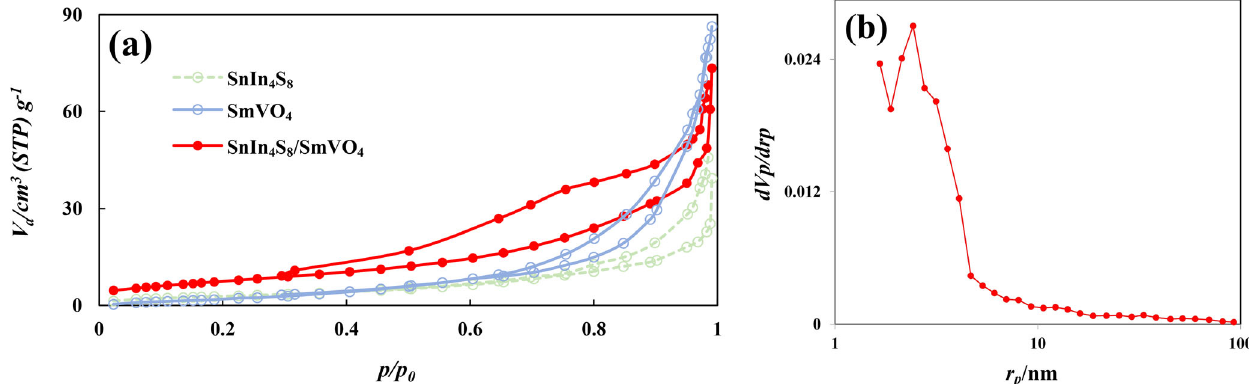
Fig. 3 N 2 adsorption-desorption and pore size distribution curves. a N 2 adsorption-desorption curves of SnIn 4 S 8 , SmVO 4 , and SnIn 4 S 8 / SmVO 4 . b pore size distribution curve of SnIn 4 S 8 /SmVO 4